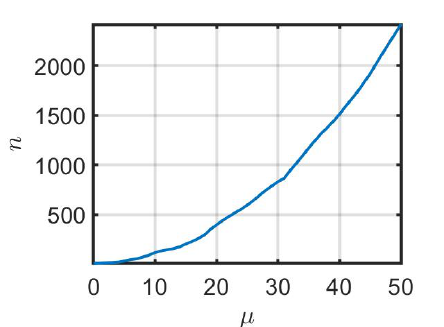
( n , q ) ( q ) to S in (10) as a function of µ over the T T